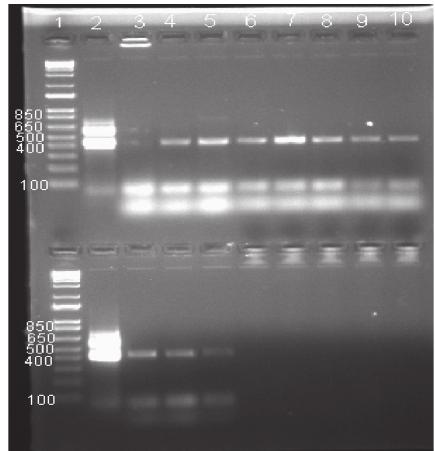
Figure 2: Multiplex PCR amplification results for detection of β -lactamase genes. Upper panel: lane 1: 1Kb plus molecular weight marker; lane 2: positive control for SHV, CTX-M, and TEM with 739, 590, and 422bp bands, respectively; lane 3: isolate 1 positive for both CTX-M and TEM with 590 and 422bp bands; lane 4: isolate 3, positive for TEM (422 bp); lane 5: isolate 4, positive for both SHV and TEM with 739 and 422 bp; lanes 6–10: isolates 5, 6, 7, 9, and 12 all positive for TEM (422bp). Lower panel: lanes 1 and 2: as in upper panel; lanes 3–5: isolates 15, 20, and 24 all positive for TEM (422